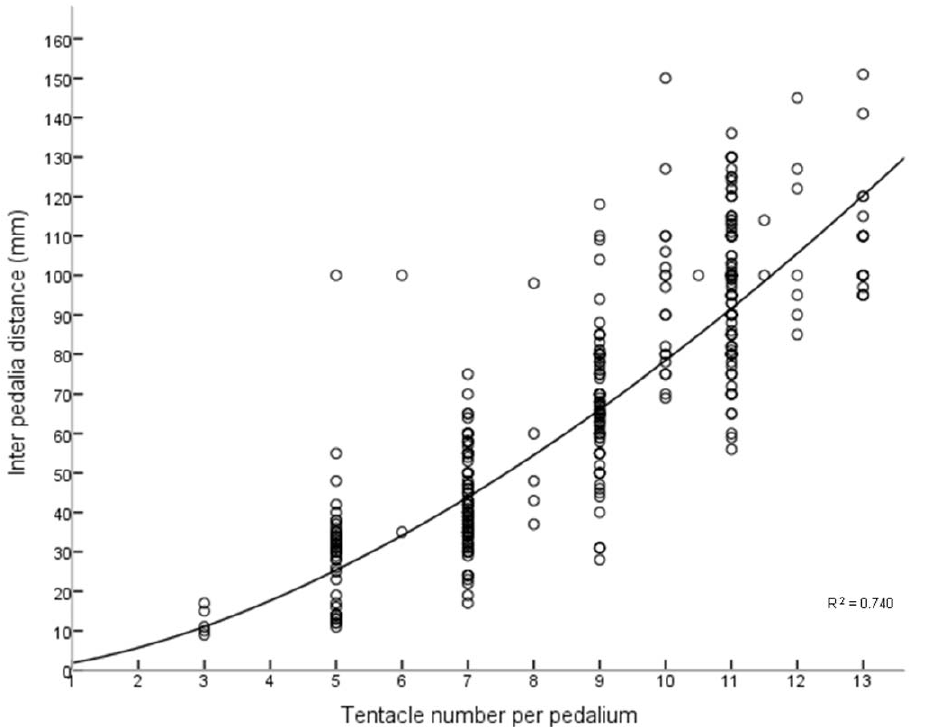
Figure 3. Positive curvelinear relationship between number of tentacles and Inter Pedalia Distance for Chironexfleckeri medusae. Inter pedalia distance is in mm and tentacle number is per pedalium.